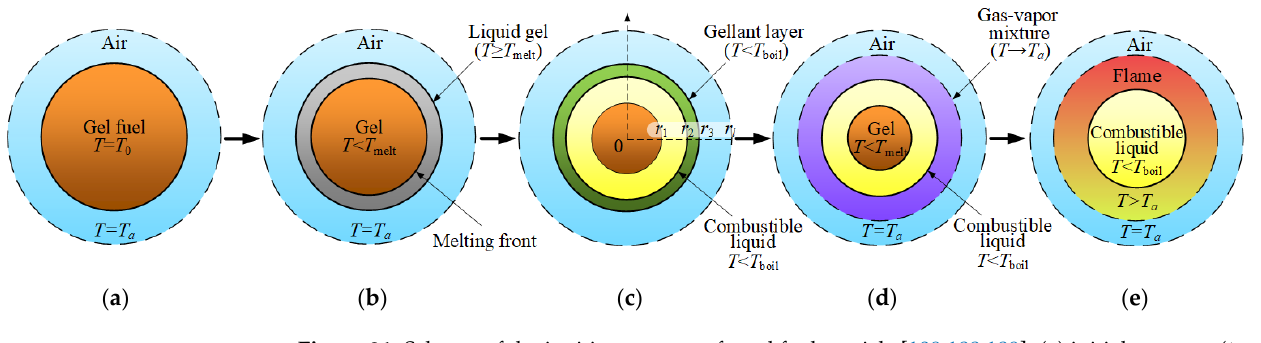
Figure 21. Scheme of the ignition process of a gel fuel particle [109,189,190]: ( a ) initial moment ( t = 0); ( b ) gel fuel melting; ( c ) separation of gel components; ( d ) formation of combustible gas-vapor mixture; ( e ) ignition moment ( t = t d ).